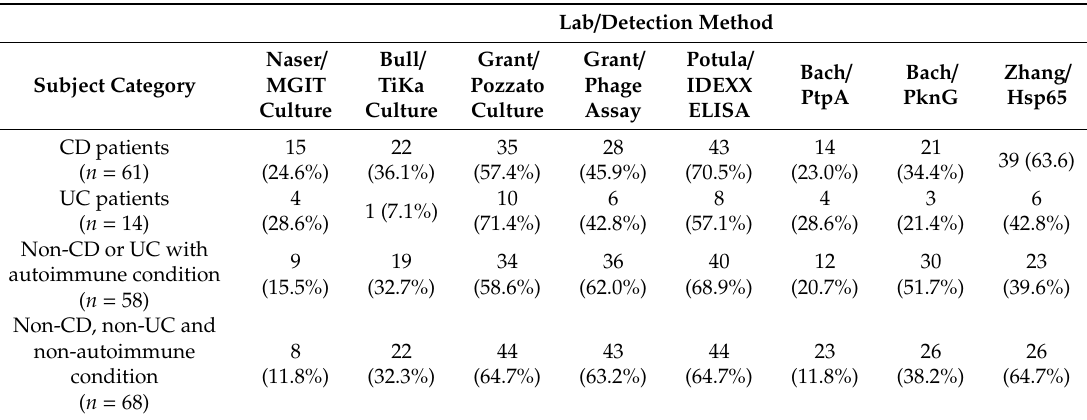
Table 4. Comparison of the number and percentages of subjects showing evidence of MAP detected by all cultural and serological methods employed; separately for CD patients, UC only patients and Non-CD controls (including 14 UC only